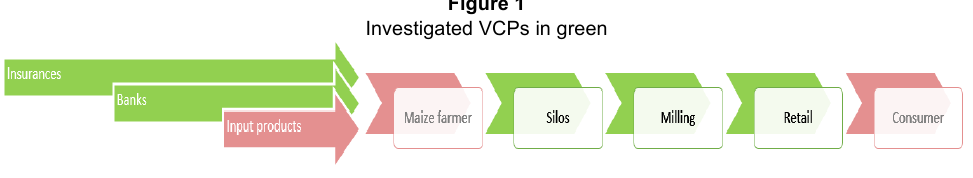
Figure 1 Investigated VCPs in